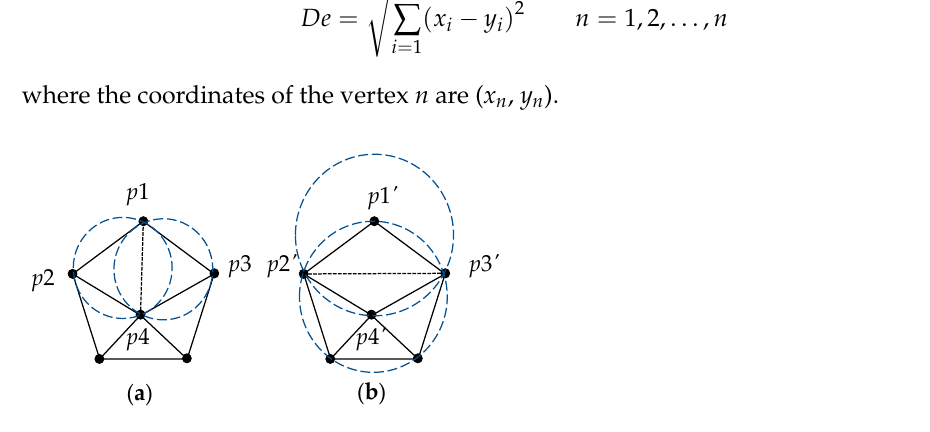
Figure 4. Delaynay triangulation with the empty circle property. ( a ) The outer circle of a triangle formed by p 1, p 2 and p 4 contains only the points of the triangle. ( b ) The outer circle of the triangle formed by p 1 ’ , p 2 ’ and p 3 ’ contains p 4 ’ and other vertices.